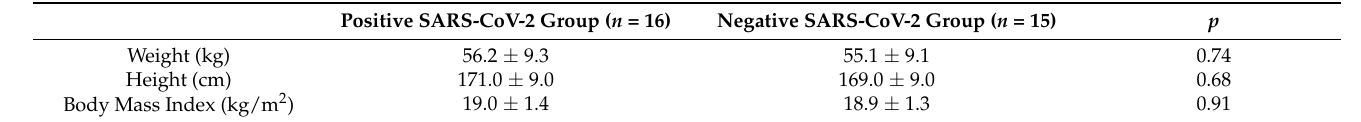
Table 2. Comparison of anthropometric parameters between positive and negative SARS-CoV-2 groups before